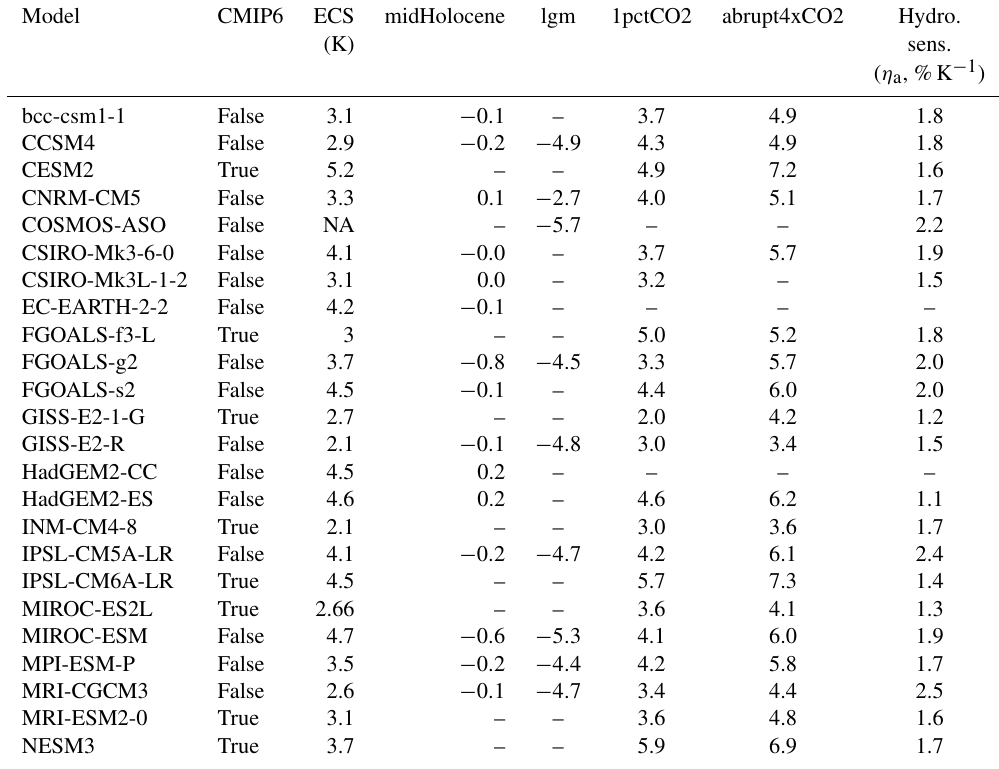
Table 1. Details of the models and experiments involved in the analysis. Each experiment provides the global mean change in surface temperature from the preindustrial control simulation ( (cid:49)T ). The (actual) hydrological sensitivity (HS) is the global mean percentage of change in precipitation divided by the temperature change. It is was calculated via linear regression through all the simulations if available. Where fewer experiments existed, it was calculated as the directed average of the values, excluding the midHolocene